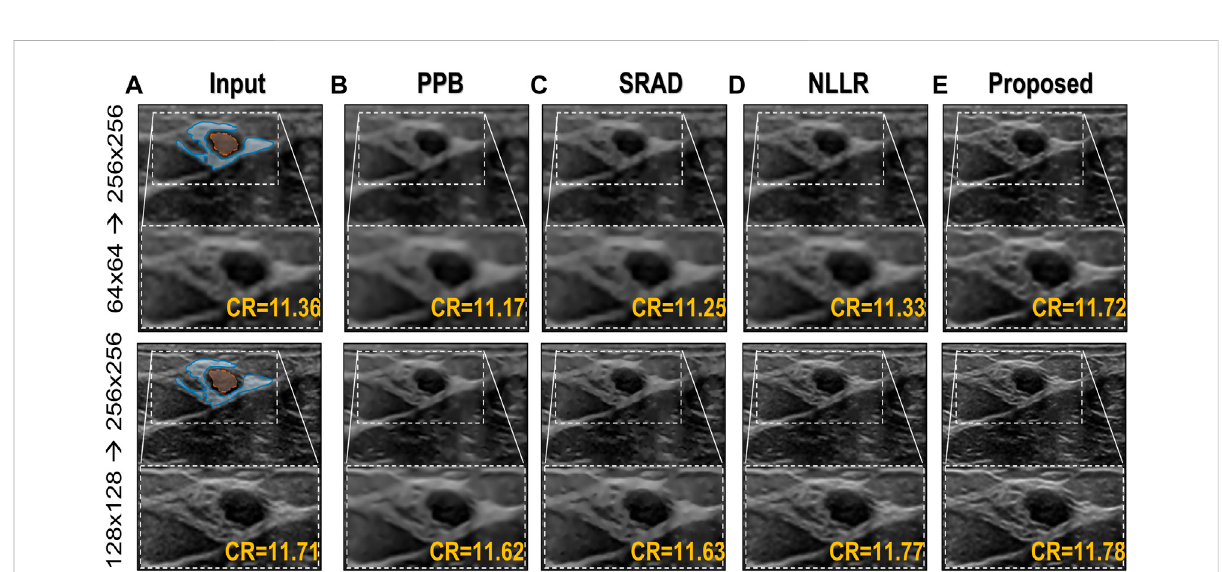
FIGURE 9 Comparison of the proposed image enhancement method with conventional speckle denoising methods. (A) Input image (B) Probabilistic Patch-Based fi lter(PPB)(Deledalleetal.,2009) fi lteredimageusing2levelsof3×3 fi lters (C) resultsofspeckle-reducinganisotropicdiffusion(SRAD) algorithm (Yu and Acton, 2002; Aja-Fernández and Alberola-López, 2006) (D) image fi ltered using NLLR (Zhu et al., 2017), and (E) Proposed model trained on noise pro fi le II (Rayleigh noise variance = 0.1, Gaussian fi lter standard deviation = 0.7)